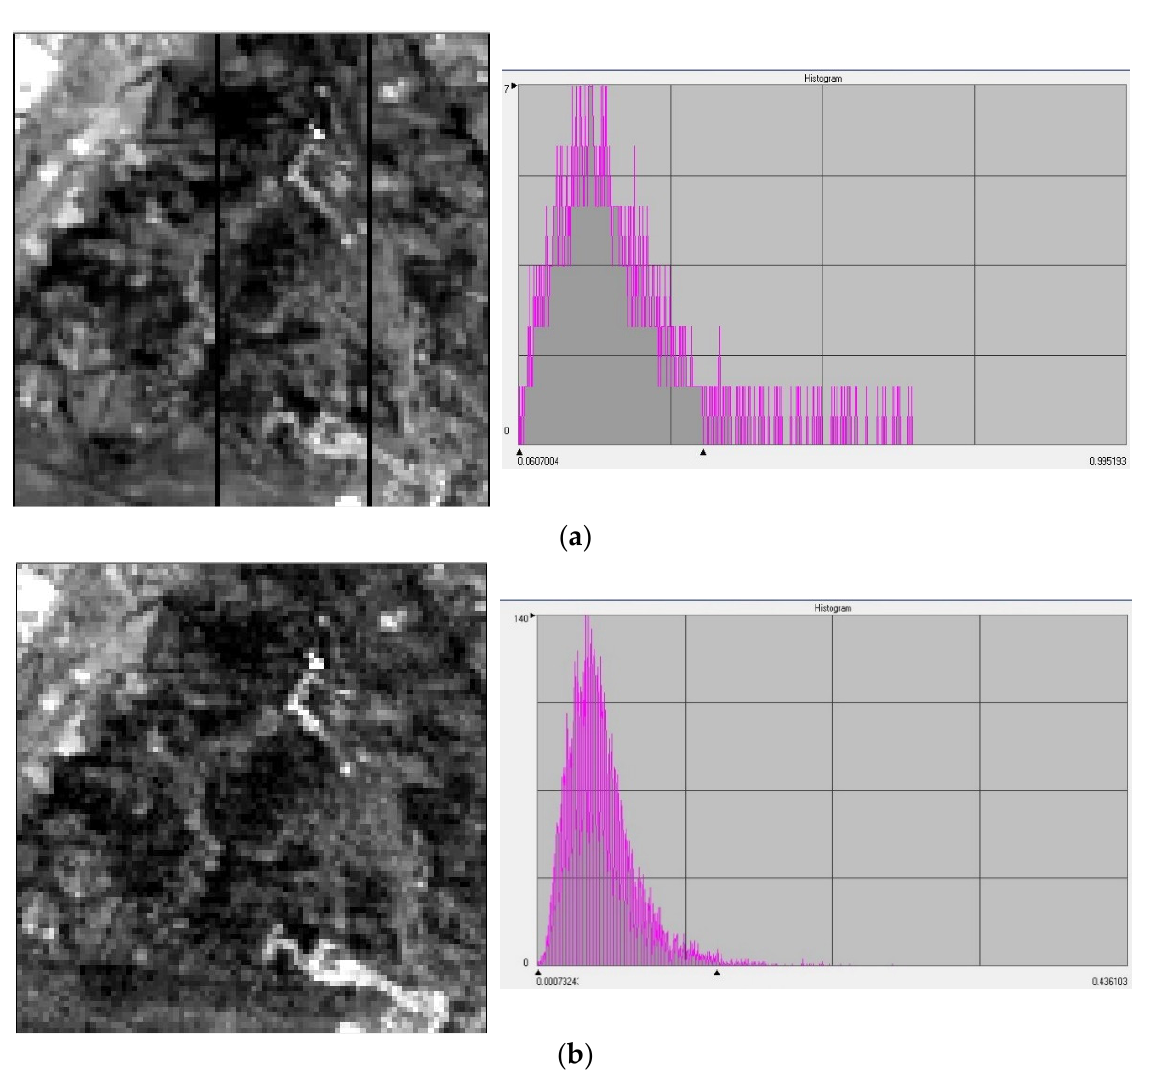
Figure 7. SWIR band ( a ) 57 (1.57 um) and ( b ) 163 (2.43 um) original images and histograms.